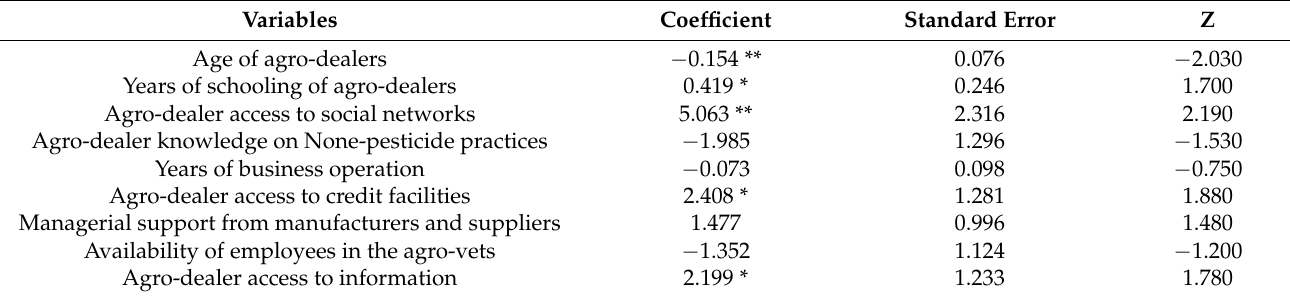
Table 5. Factors influencing willingness to stock for a fungal-based Biopesticide (ICIPE 20) in Kirinyaga